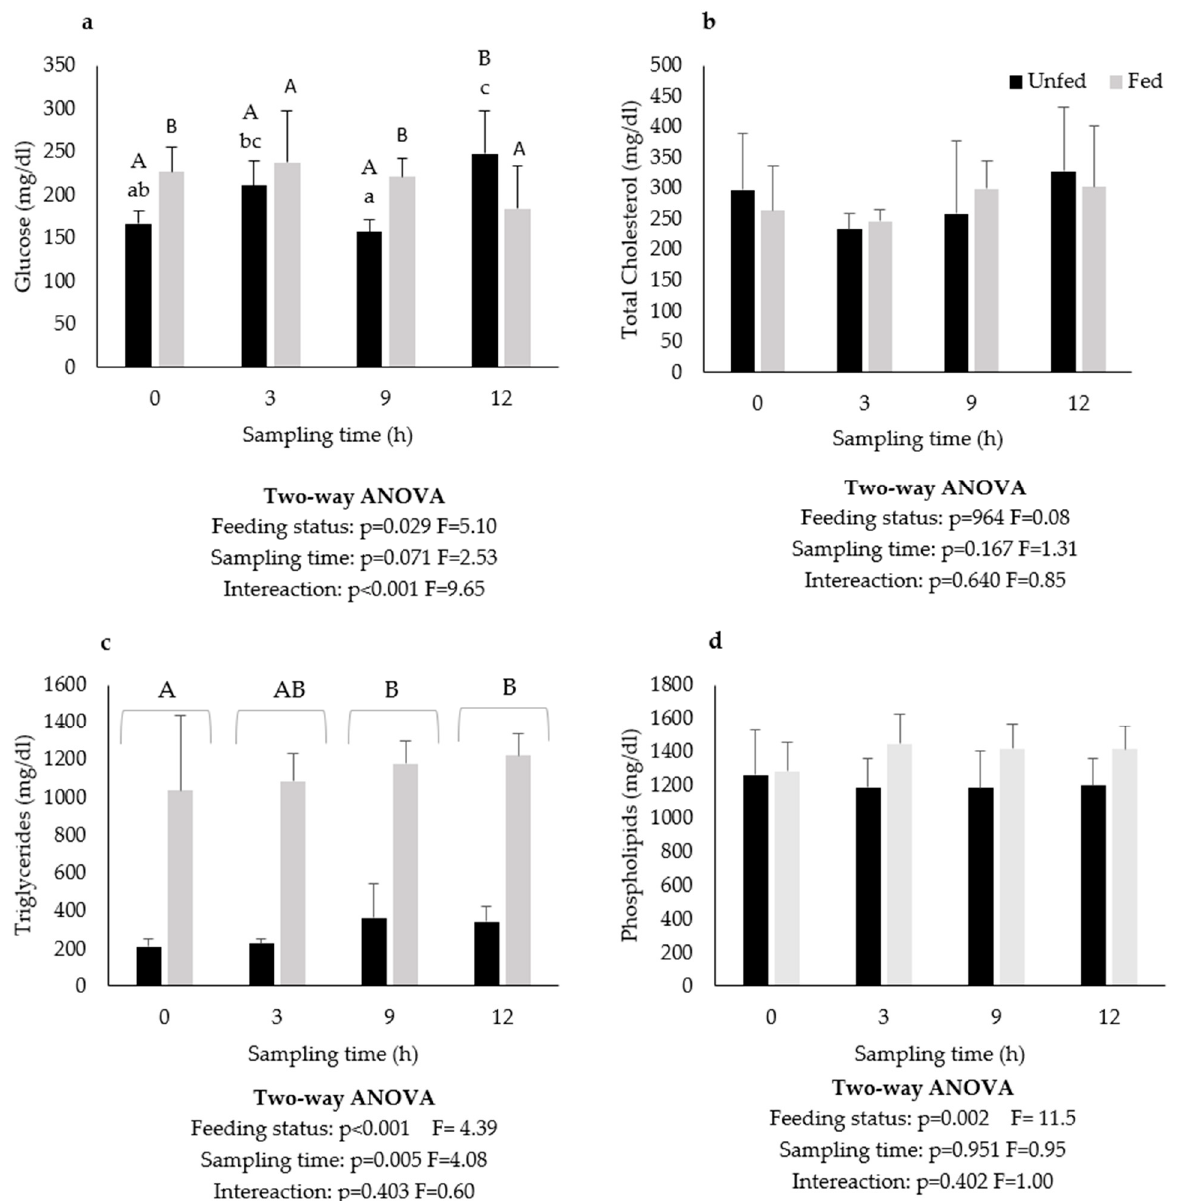
Figure 2. Plasma glucose ( a ), total cholesterol ( b ), triglyceride ( c ), and phospholipid ( d ) levels of European seabass juveniles after 8 days pf feed deprivation (unfed) or continuous feeding (fed). Values are presented as means (n = 6) and standard error (SE). Small letters denote significant differences in sampling times regardless of feeding conditions and capital letters denote significant differences in sampling times between feeding